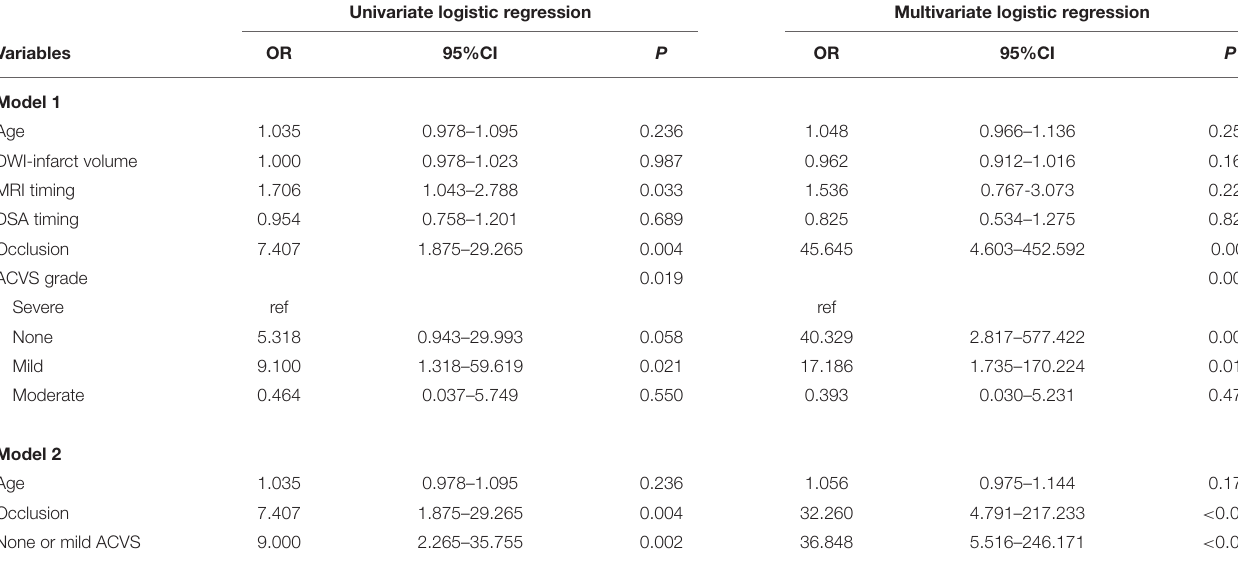
TABLE 2 | Logistic regression analysis of a good collateral circulation confirmed by DSA.